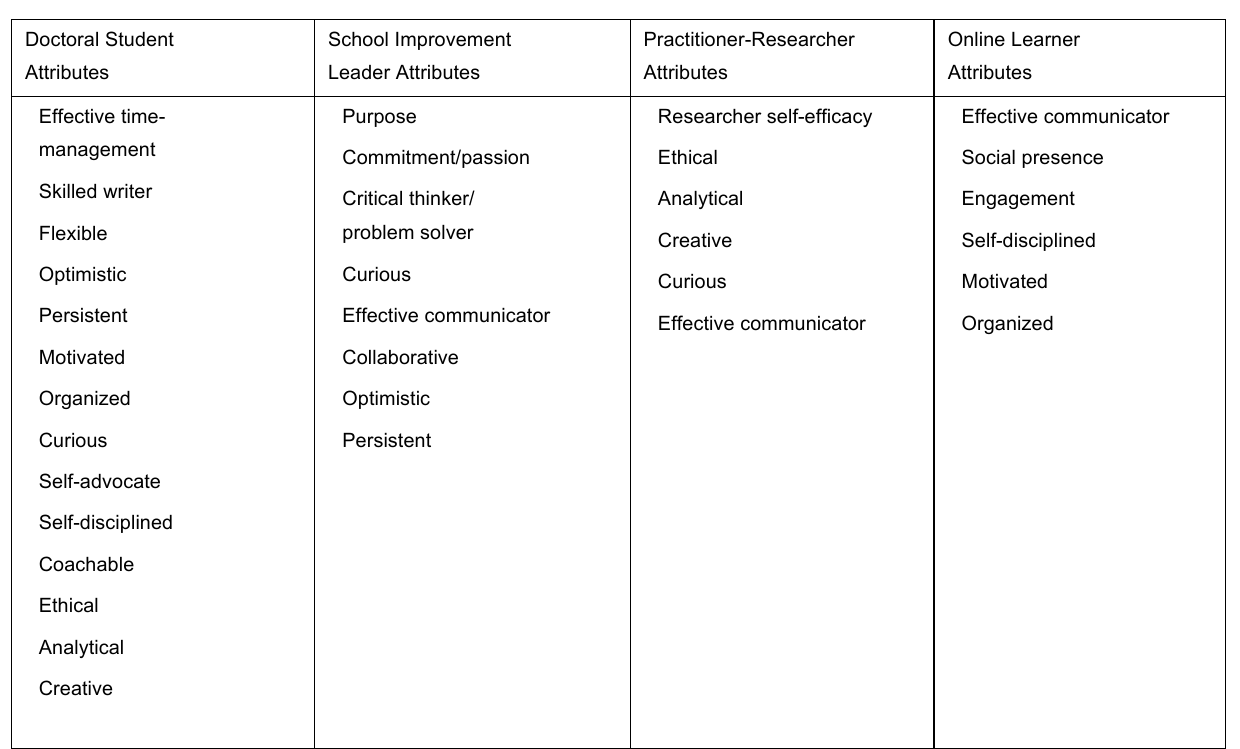
Table 1. Attributes of an Effective School Improvement Ed.D. Student